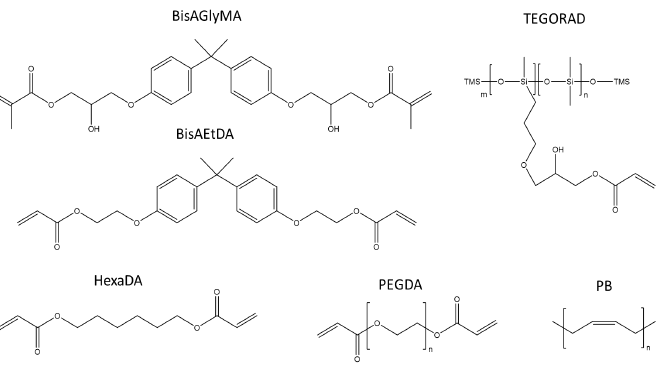
Figure 2. Scheme of the curing agents used in the preliminary part of this